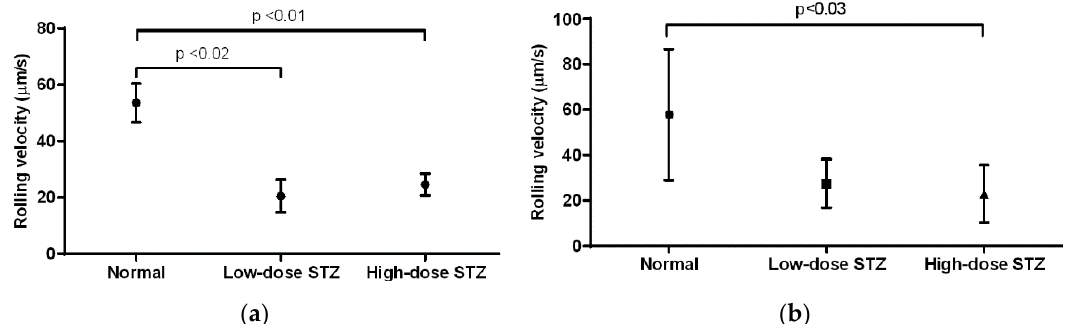
Figure 5. Effects of moderate and severe diabetes in the rolling velocity of neutrophils. ( a ) Mean values of rolling velocity ( μ m/s) of neutrophils in the cremaster muscle of normal, low-dose STZ, and high-dose STZ diabetic mice ( n = 6). Compared to normal mice, mice given low doses of STZ exhibited decreased rolling velocity ( p < 0.02), while mice given higher doses also exhibited decreased rolling velocity ( p < 0.01). Overall, diabetic mice showed decreased rolling velocity compared to that of normal mice. ( b ) Mean values of rolling velocity ( μ m/s) in the earlobe of normal, low-dose STZ, and high-dose STZ diabetic mice ( n = 6). Compared to normal mice, mice given high doses of STZ showed a decreased rolling velocity ( p < 0.03).